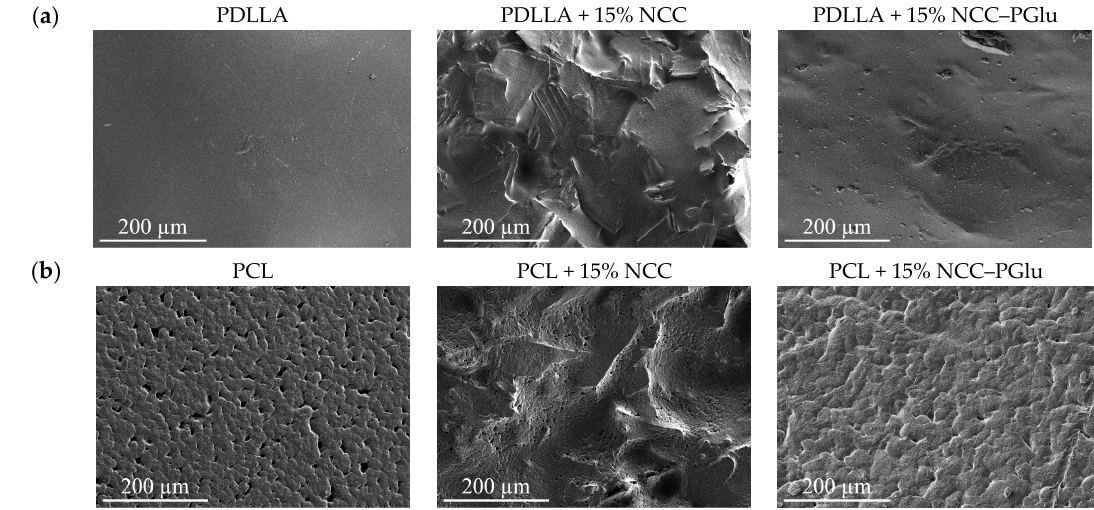
Figure 3. SEM images of PDLLA-based ( a ) and PCL-based ( b ) pure and composite films (500 × ).